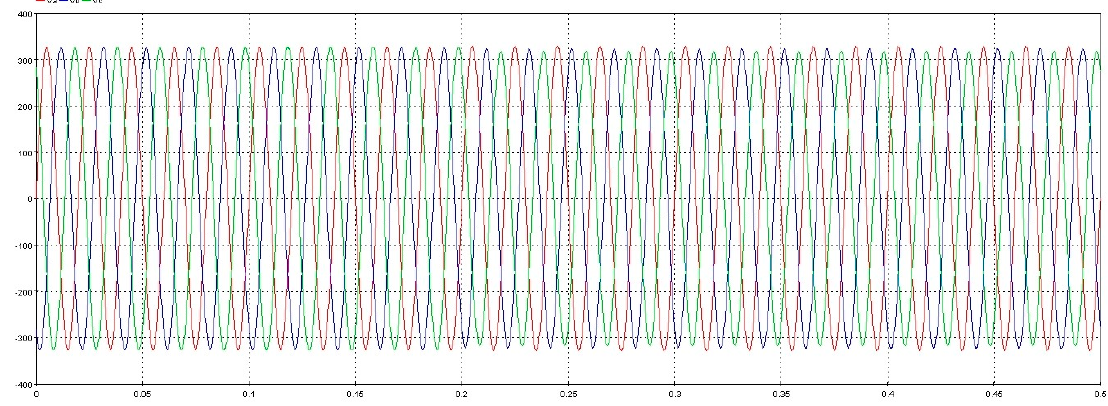
Figure 16. The voltage waveform of fuzzy droop control strategy under sliding mode control.